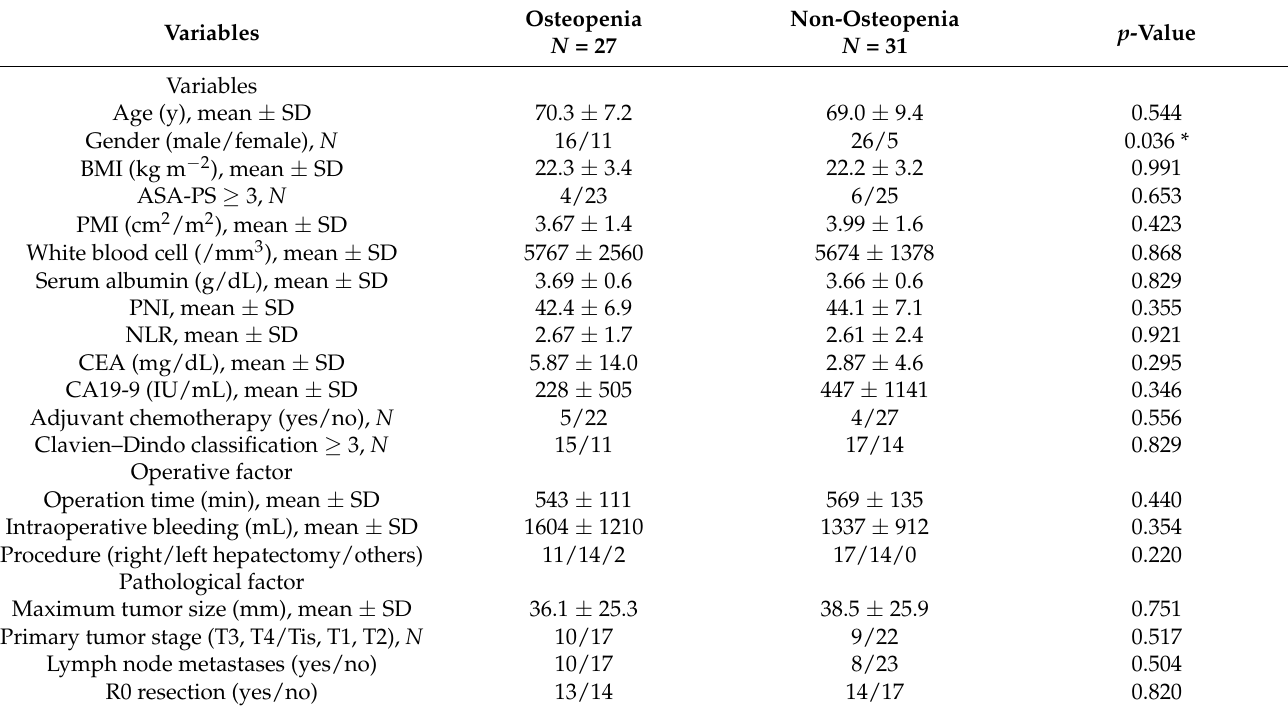
Table 1. Clinicopathological factors of patients with and without